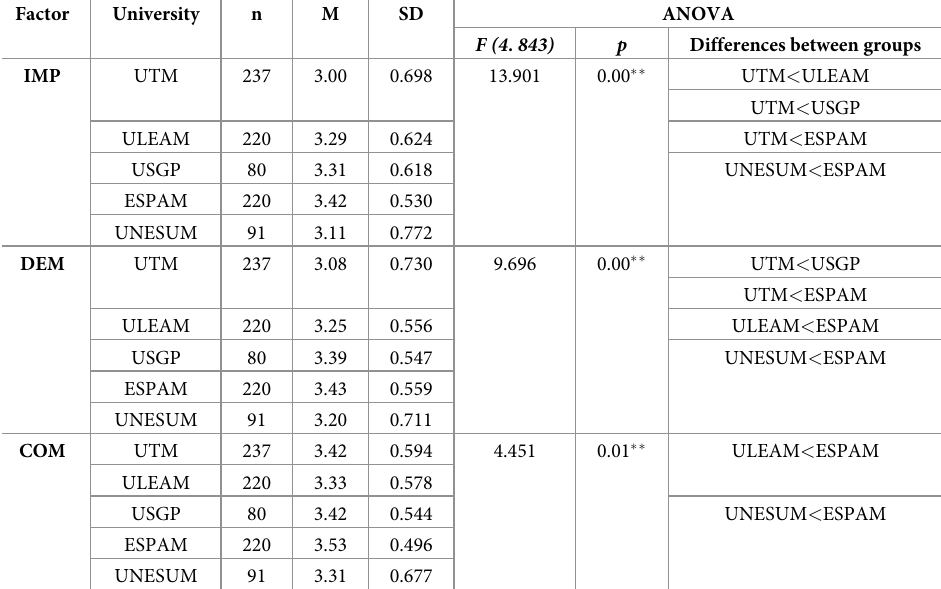
Table 5. Differences in the scale factors for university tutoring by university.